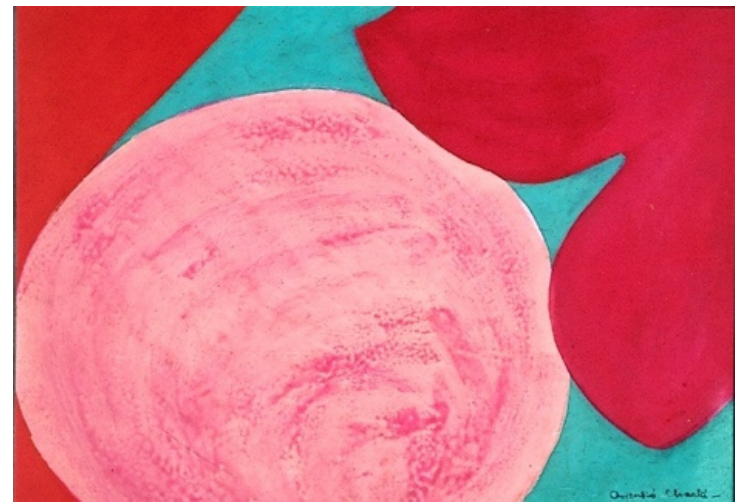
Figure 6. Mari Chordà Autorretrat embarassada, novè mes (Pregnant Self Portrait, Ninth Month), 1966. Creative Commons Attribution-Share Alike 3.0 Unported License.